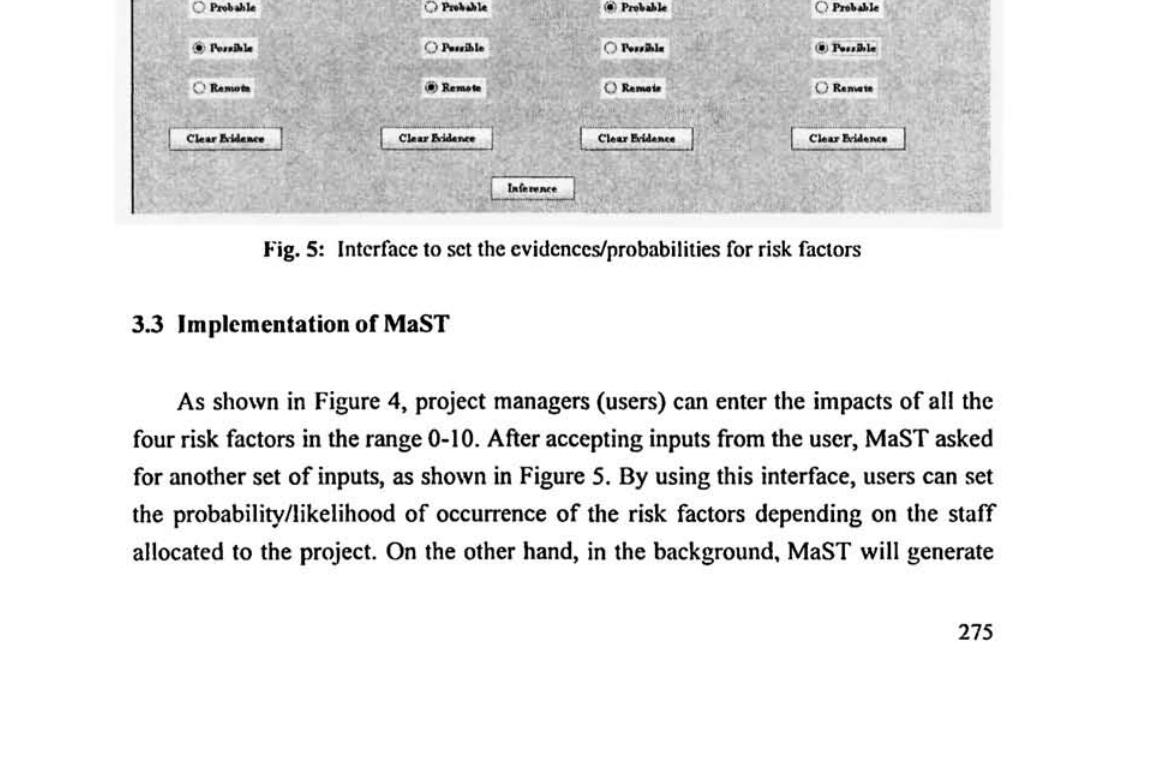
Fig. 4: Interface to input impact of risk factors